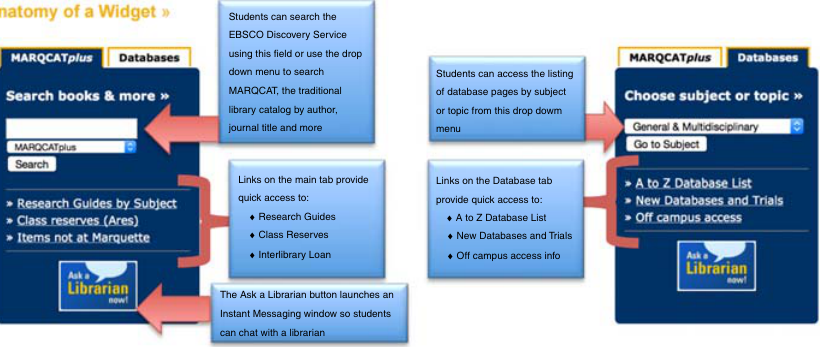
Figure 3. Anatomy of library